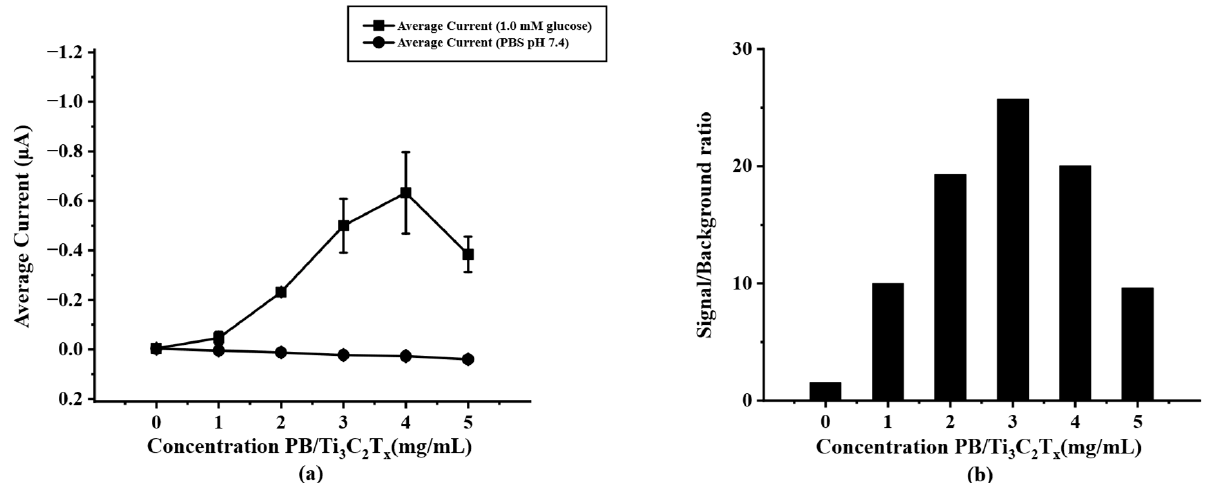
Figure 4. ( a ) current response of PB/Ti 3 C 2 T x /GOx/Nafion/SPIL-GE at different concentrations of PB/Ti 3 C 2 T x nanocomposites using chronoamperometry (applied potential at 0 V vs. Ag/AgCl) in 1.0 mM glucose, ( b ) S/B ratio at different concentrations of PB/Ti 3 C 2 T x nanocomposites according to the results in figure ( a